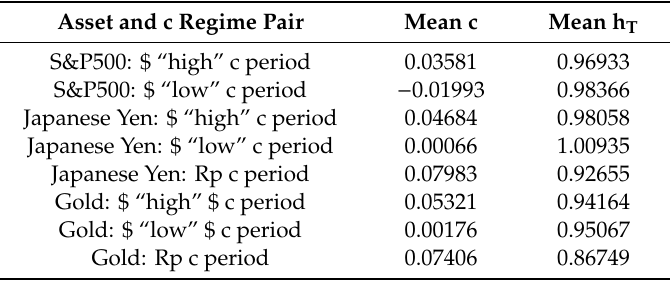
Table 7. Mean c and Mean h T .